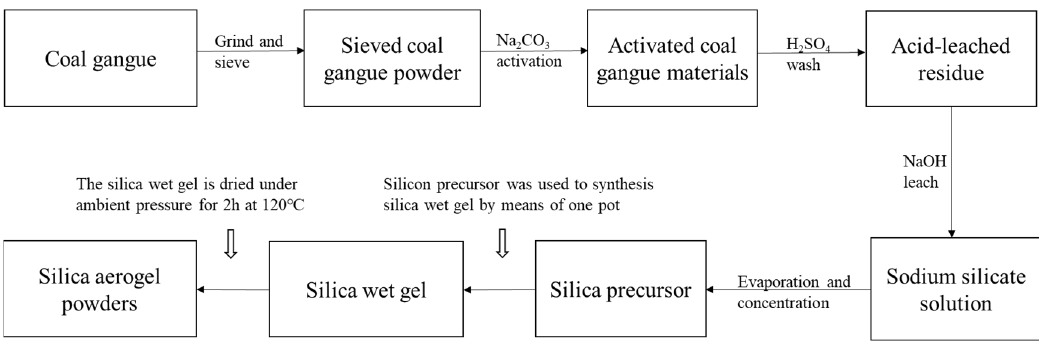
Figure 2. The specific preparation procedure of SiO 2 aerogel powders by recycling coal gangue.